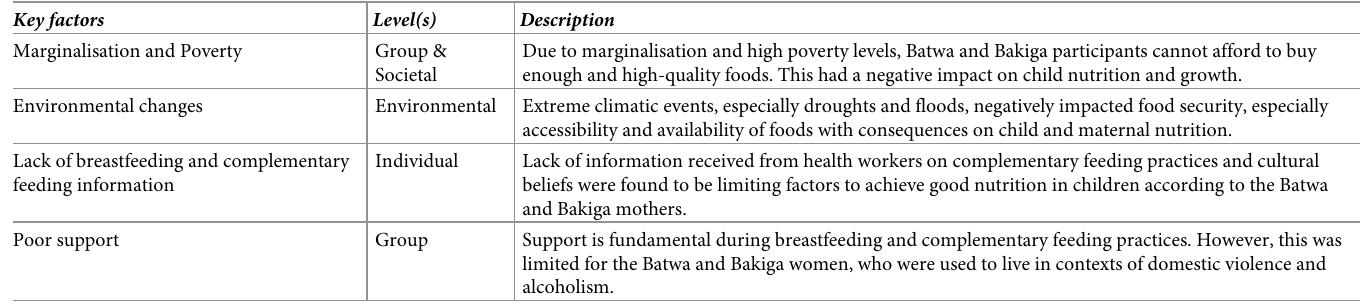
Table 2. Summary of the key factors affecting breastfeeding and complementary feeding according to the participants in the FGD. For each key factor we identified the correspondant level(s) explained in the framework (Fig 1). Key